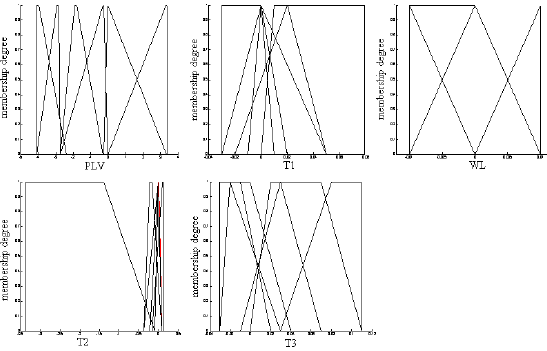
Fig. 14. Projection of the six clusters onto the input variables